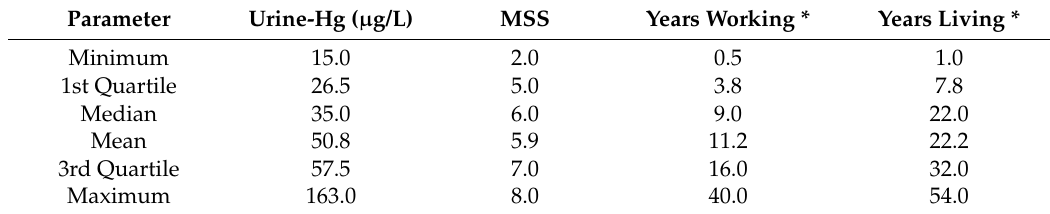
Table 2. Summary of mercury related characteristics ( n = 44).